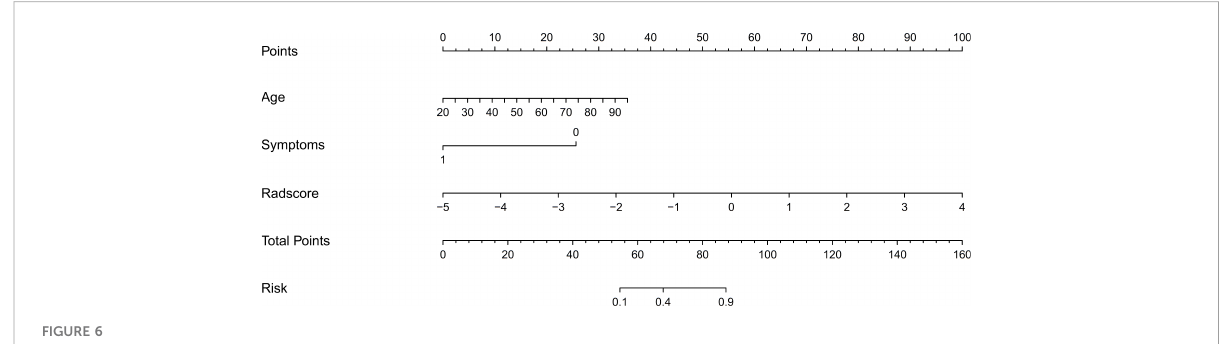
FIGURE 6 Nomograms constructed in this study using the training